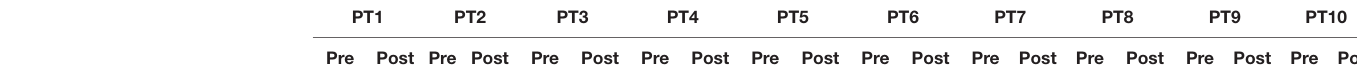
TABLE 5 | Detailed description of neuropsychological pre- and postoperative evaluation tests